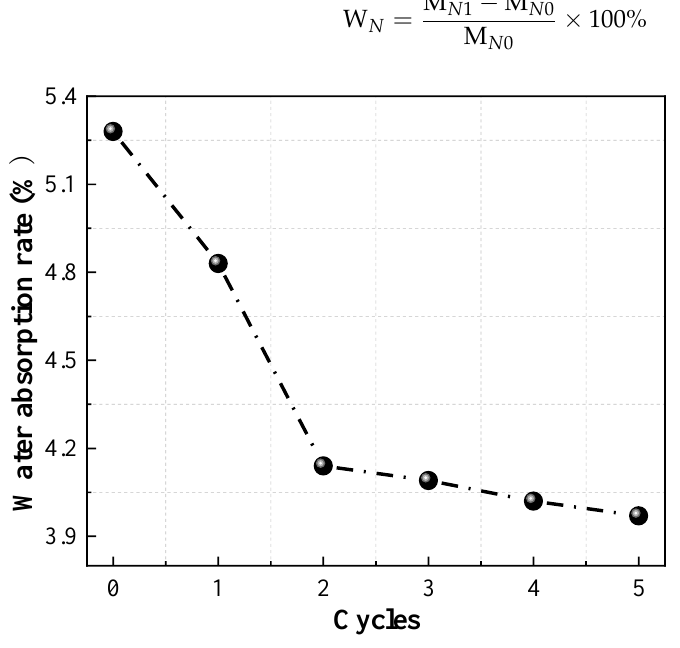
Figure 2. Water absorption rate of Pisha sandstone specimens at different wet – dry cycles.